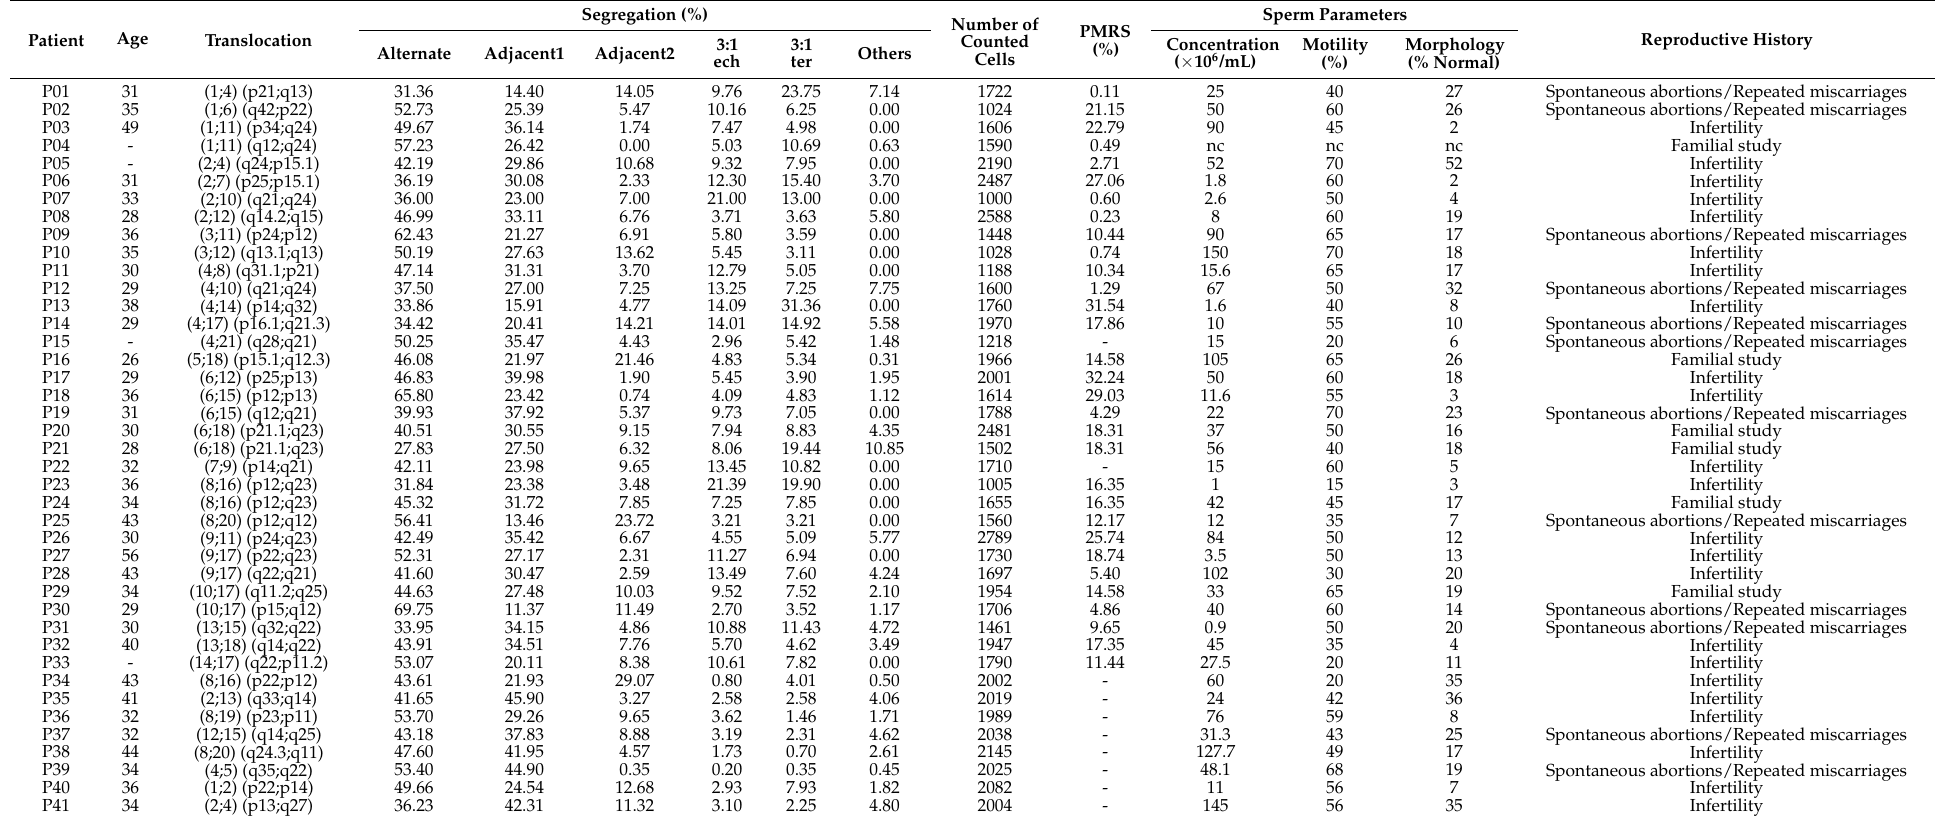
Table 1. Reciprocal translocation carriers: age, translocation, meiotic segregation, number of cells counted, PMRS (risk of having a child with a polymalformative mental/retardation syndrome), semen parameters and reproductive history. 3:1 ech: 3:1 exchange; 3:1 ter: 3:1